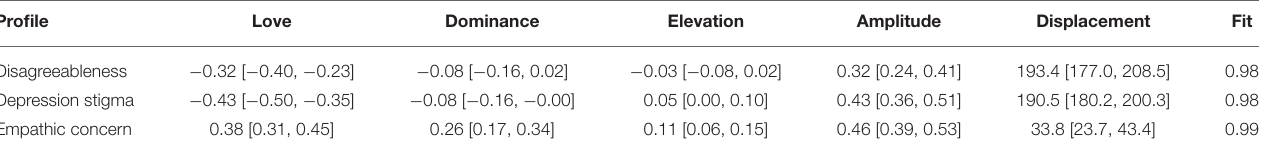
TABLE 1 | Structural summary parameters with 95% confidence intervals in Study